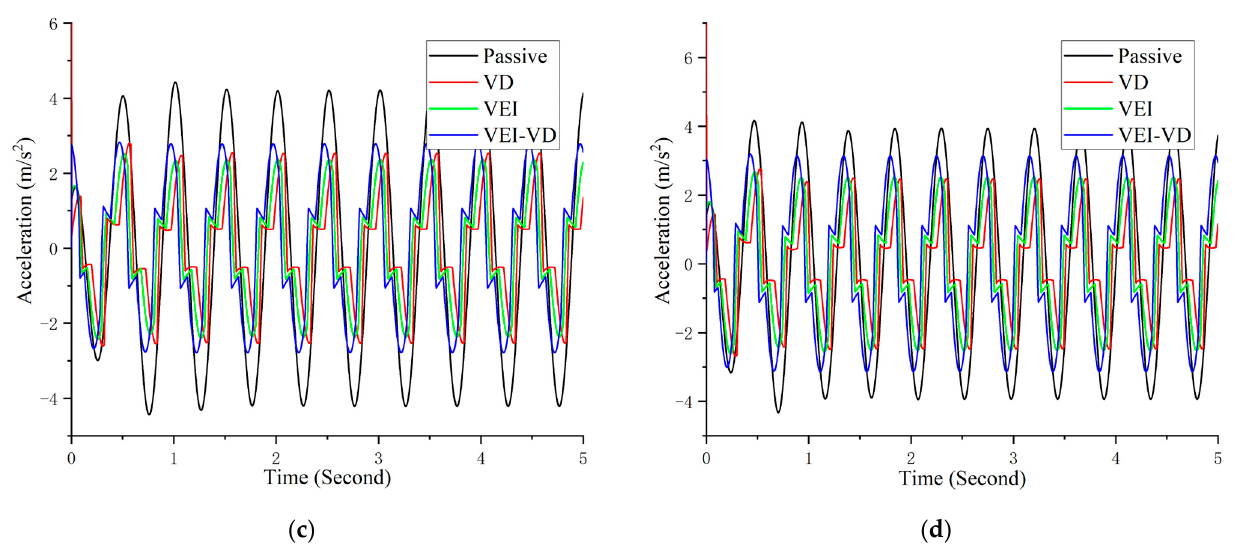
Figure 16. Acceleration under different sinusoidal excitation: ( a ) f 1 = 1.0 Hz; ( b ). f 2 = 1.5 Hz; ( c ). f 3 = 2.0 Hz; ( d ). f 4 = 2.5 Hz. Table 2. The RMS acceleration reduction of different sinusoidal excitation.